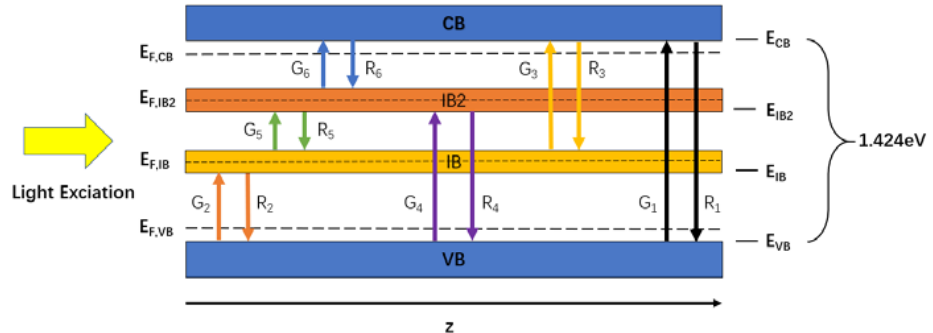
Figure 2. Solar cell with energy bands and transitions of dual intermediate bands. GaAs is a barrier material, and IB and IB2 are the dual intermediate bands.